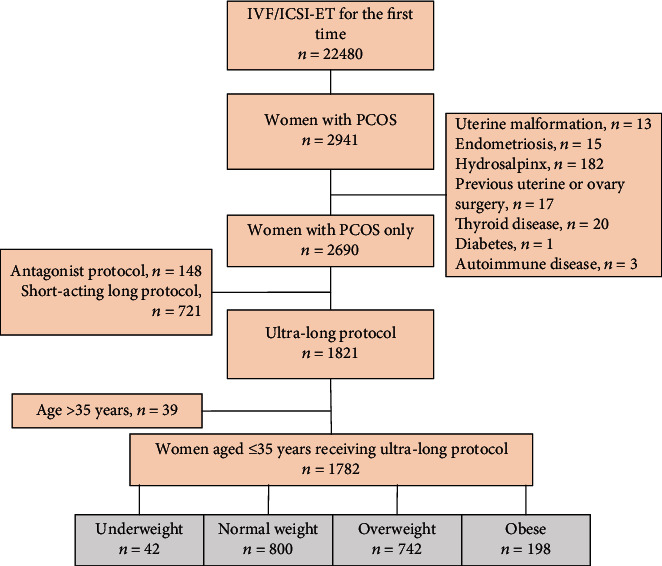
Study flow chart.